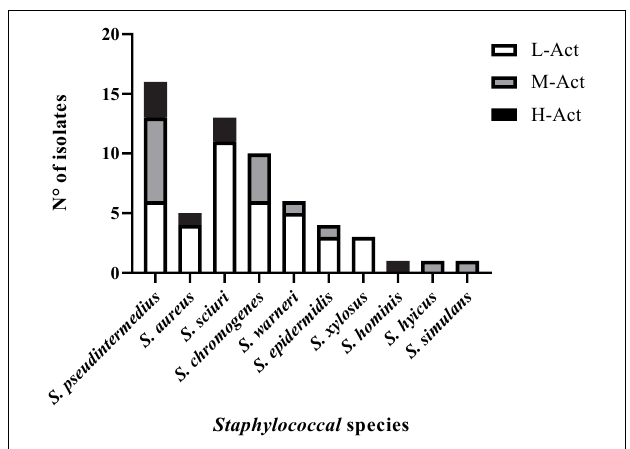
FIGURE 2 | Antimicrobial activity level [low (L-Act), medium (M-Act), or high (H-Act)] of the 60 BLIS + isolates (of 10 staphylococcal species) according to the percentage of indicator bacteria inhibited (L-Act: < 20%; M-Act: 20–70%; H-Act: >